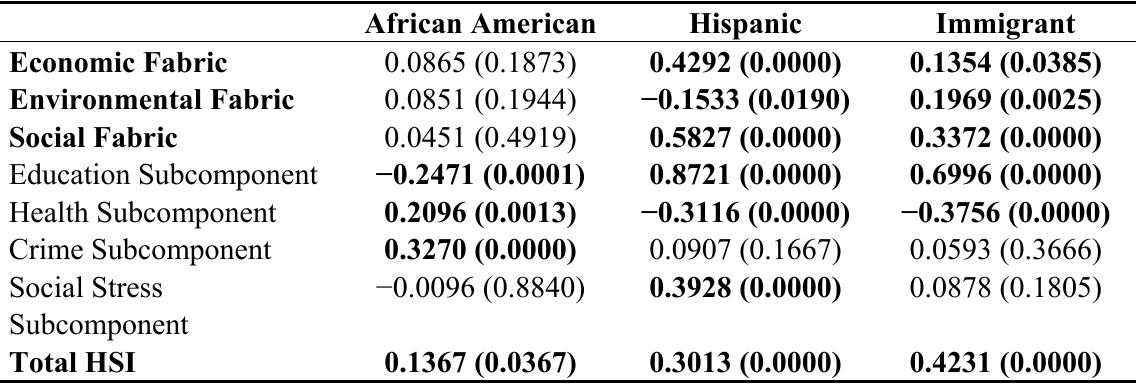
Table 3. Correlation matrix for HSI fabrics and subcomponents with county-level African American and Hispanic ethnic